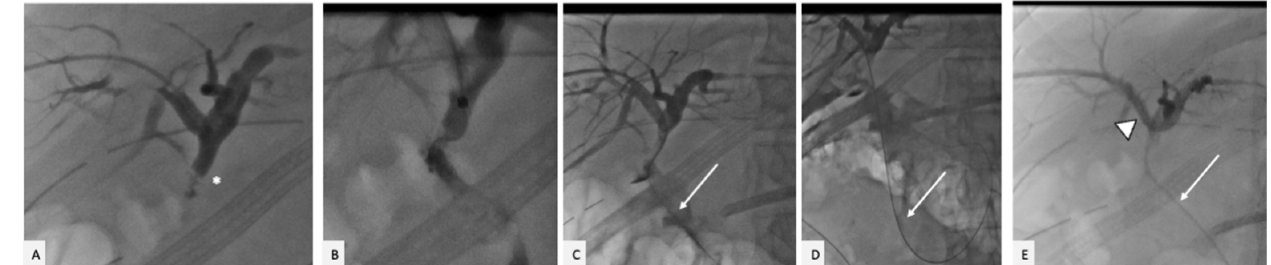
Figure 3. ( A ) Percutaneous cholangiography confirming the HJA stenosis (*) and the small bile leak into the peritoneal cavity ( B ). ( C – E ) A percutaneous drainage (8 Fr) was positioned into the biliary tree (arrowhead), and a hydrophilic 4 Fr angiographic catheter (arrows) was placed, passing through the biliary leak into the peritoneal cavity.